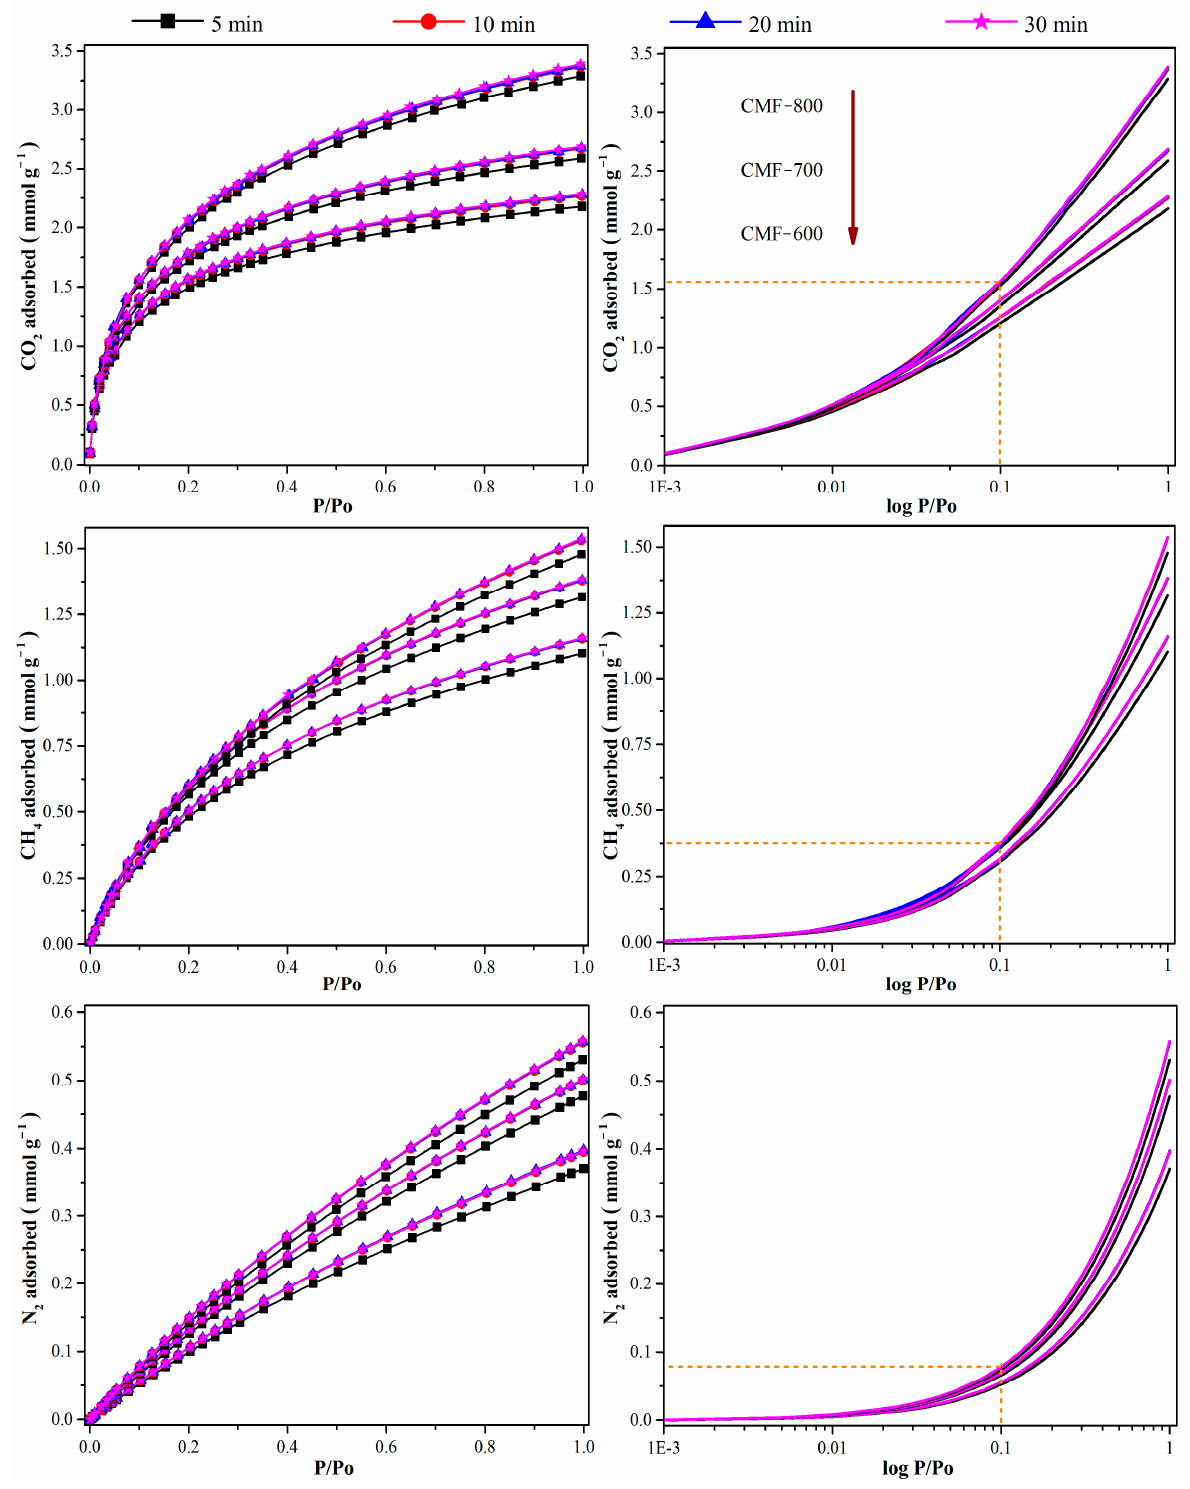
Figure 7. CO 2 , CH 4 , and N 2 isotherms at 0 °C with equilibration time of 5, 10, 20 and 30 min.